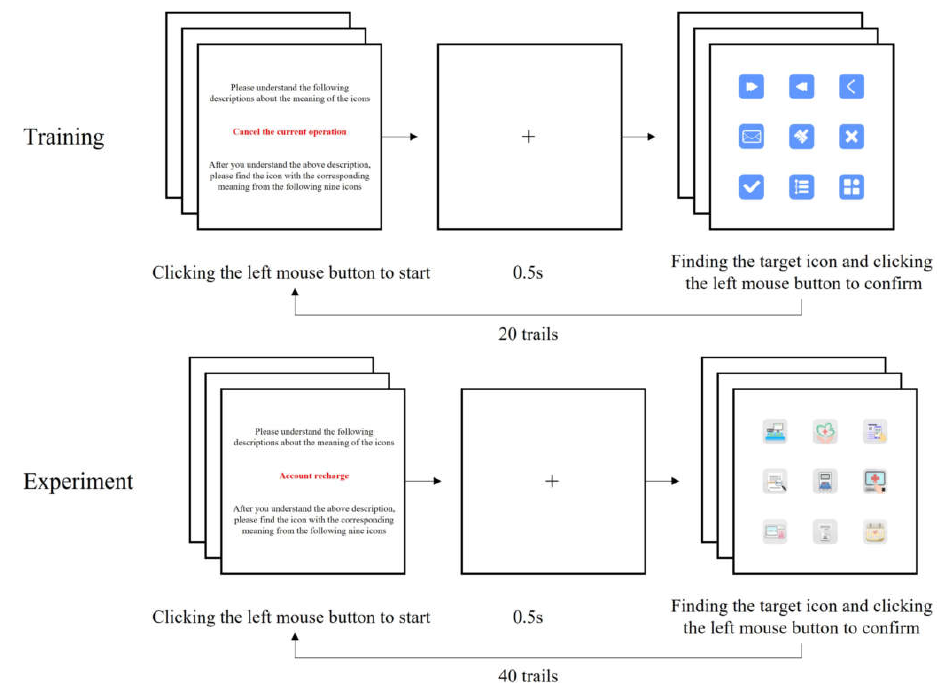
Figure 3. Schematic diagram of the experimental procedures. Participants were required to first read a text description of the target icon and click the left mouse button to go to the next page after understanding the description. Each test began with gazing at the cross for 0.5 s, and subsequently, the screen automatically switched to a 3 × 3 array of icons. Participants were required to select an icon that matched the target meaning and to click the left mouse button to confirm their selection. The screen